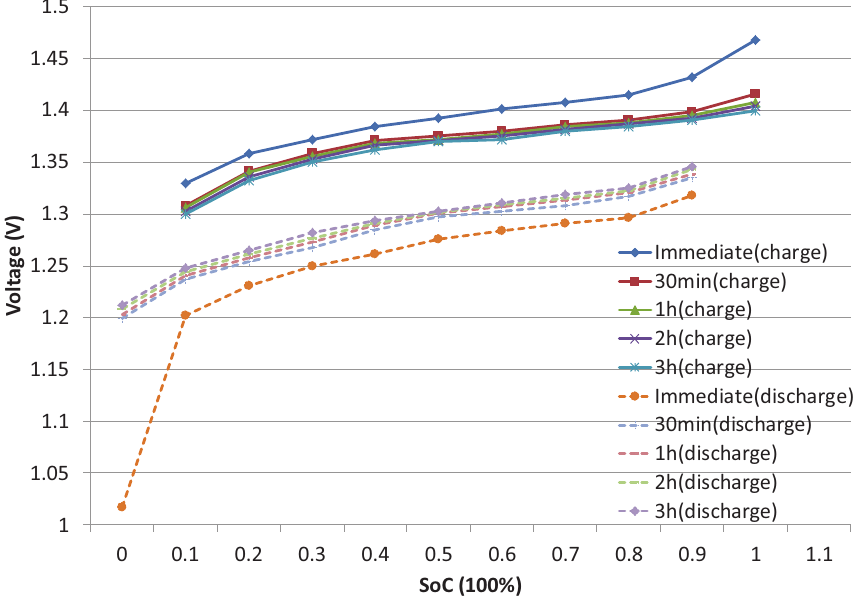
Figure 6. The OCV curve of charging and discharging after laying aside for difference time. The data is obtained by charging and discharging experiment using 6 A current. The nominal voltage and the nominal capacity of tested battery cell are 1.2 V and 1